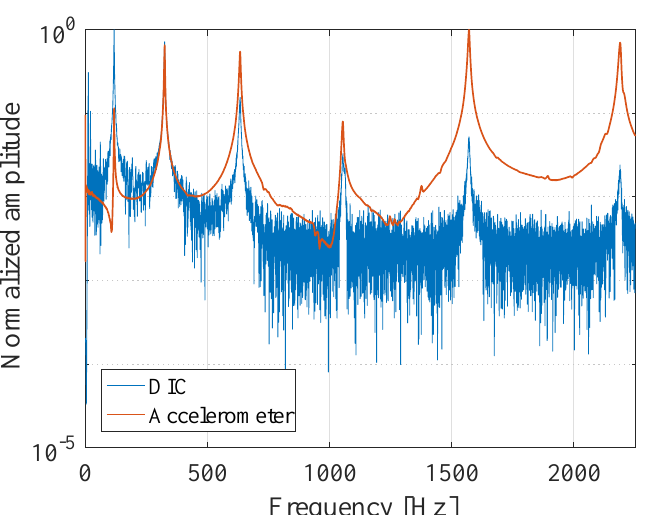
Figure 19. Fourier transforms obtained from the accelerometer and the DIC for the neutral axis point of the clamped–clamped beam at abscissa x = 14.10